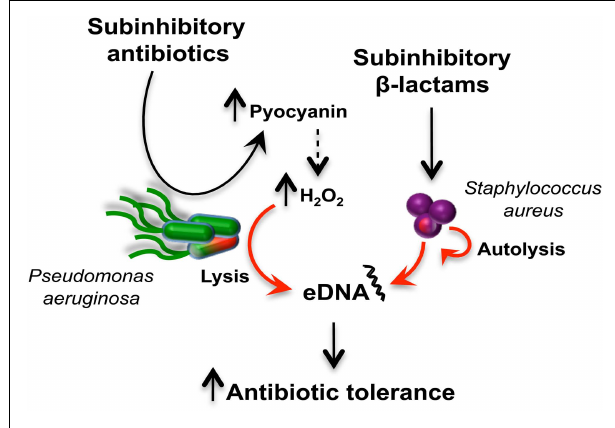
FIGURE 4 |Antibiotic induction of extracellular DNA (eDNA) release in a multispecies community and antibiotic tolerance. The schematic represents how two bacterial species, P. aeruginosa (green) and S. aureus (purple), respond to subinhibitory antibiotics to release eDNA. Subinhibitory antibiotics induced the production of pyocyanin (Shen etal., 2008), which is associated with increased H 2 O 2 levels responsible for cell lysis and DNA release (Das and Manefield, 2012). In S. arureus , exposure to subinhibitory β -lactam antibiotics induces release of eDNA via an autolysis-dependent mechanism (Kaplan etal., 2012).The release of eDNA by both bacteria can induce antibiotic tolerance in communities (Mulcahy etal., 2008).